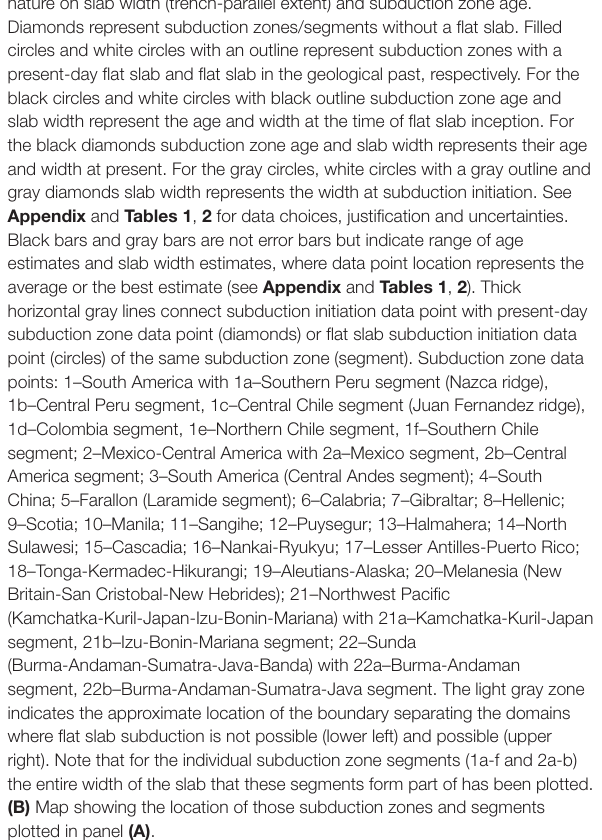
segment, 22b–Burma-Andaman-Sumatra-Java segment. The light gray zone indicates the approximate location of the boundary separating the domains where flat slab subduction is not possible (lower left) and possible (upper right). Note that for the individual subduction zone segments (1a-f and 2a-b) the entire width of the slab that these segments form part of has been plotted. (B) Map showing the location of those subduction zones and segments plotted in panel (A)